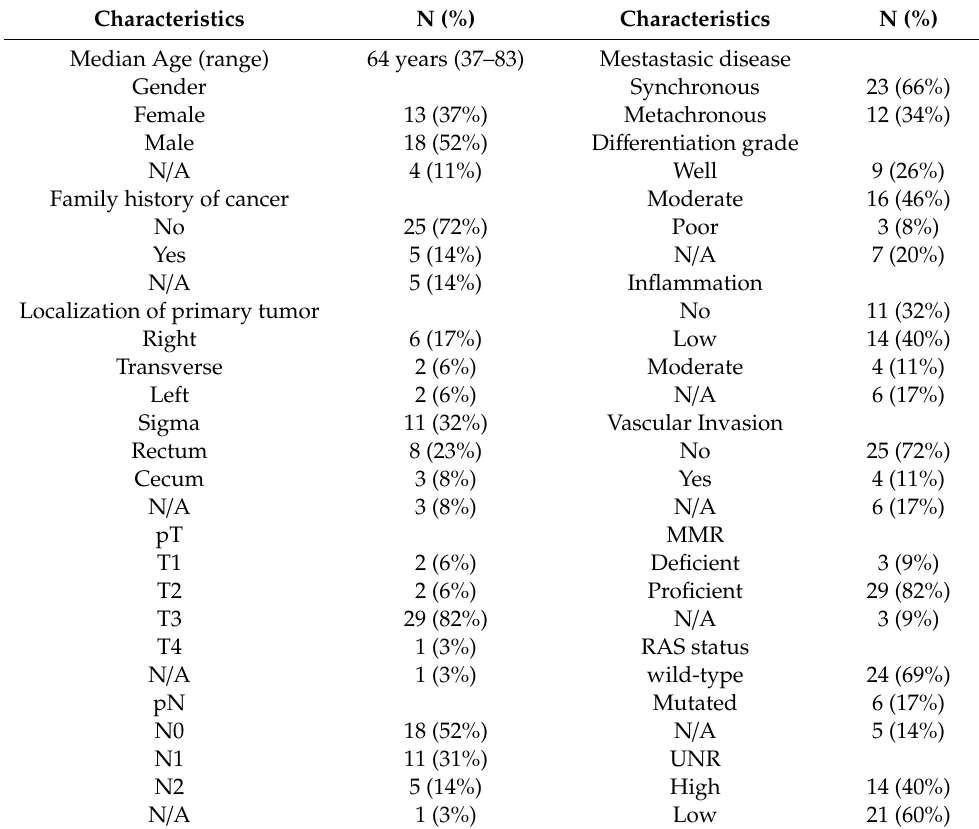
Table 1. Clinico-pathological characteristics of CRC patients from training set included in the study.